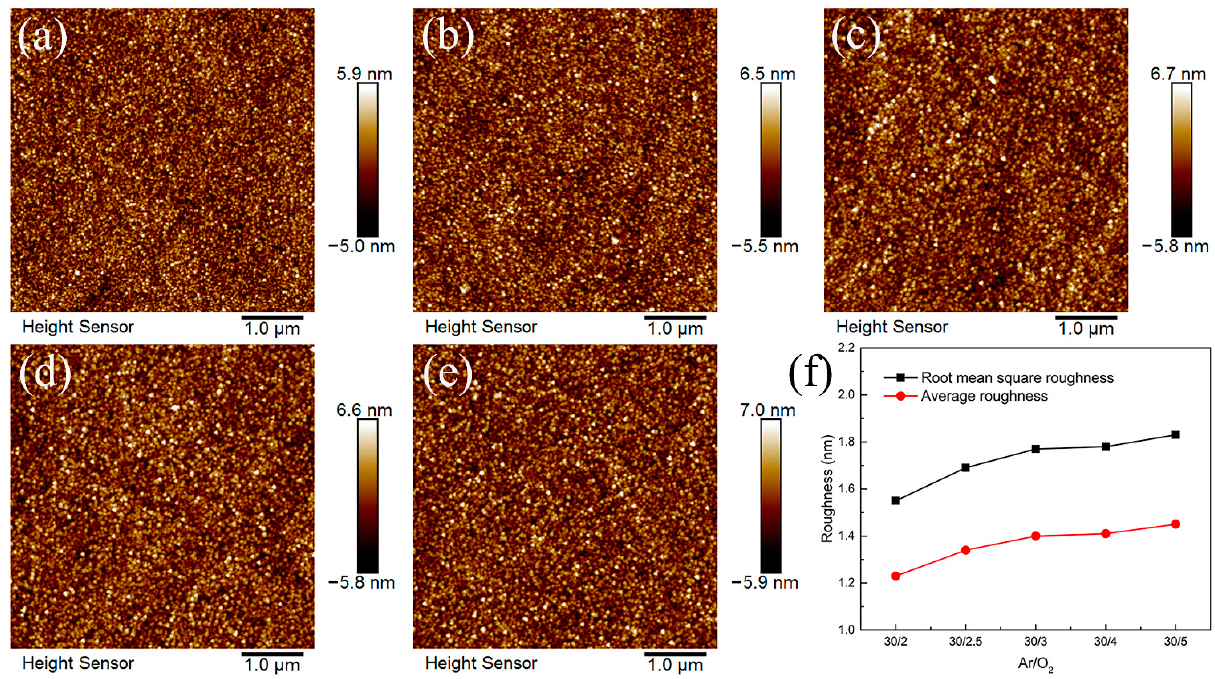
Figure 4. AFM images of the TaO x films with various Ar/O 2 ratio, ( a ) 30/2, ( b ) 30/2.5, ( c ) 30/3, ( d ) 30/4, ( e ) 30/5, and ( f ) change trend of roughness of TaO x films.